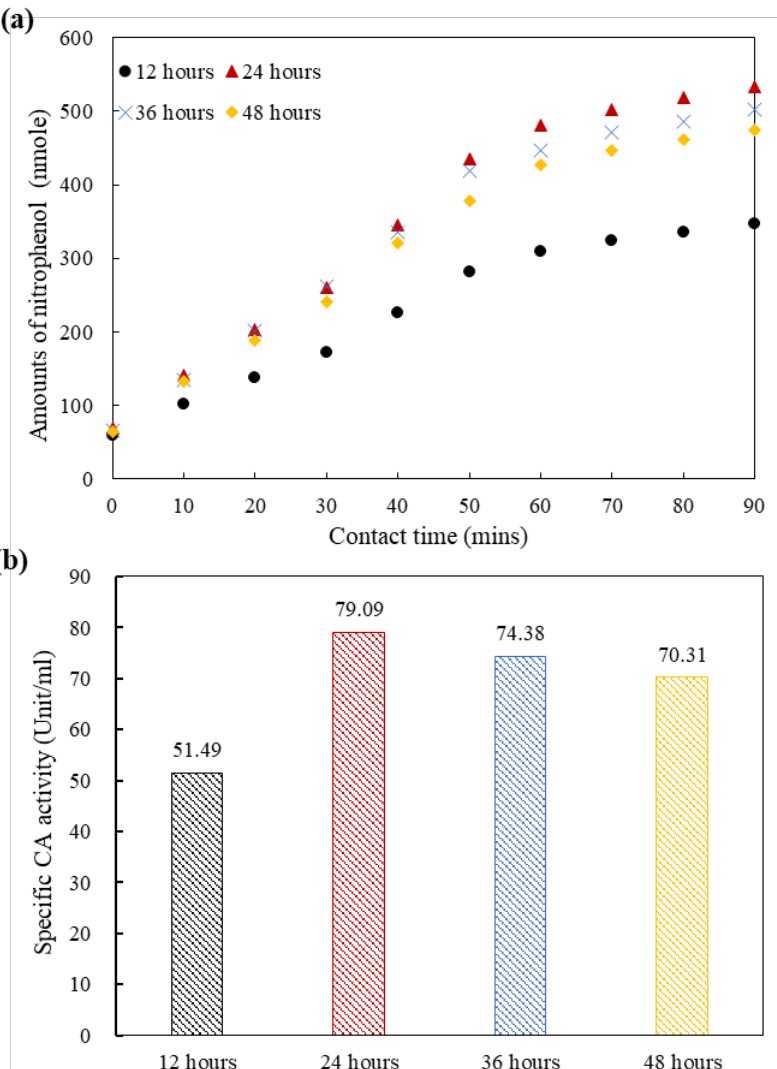
Figure 2. ( a ) Enzyme reaction rate and ( b ) specific activity of carbonic anhydrase extracted from SAML2018 after 12, 24, 36, and 48 h of incubation.